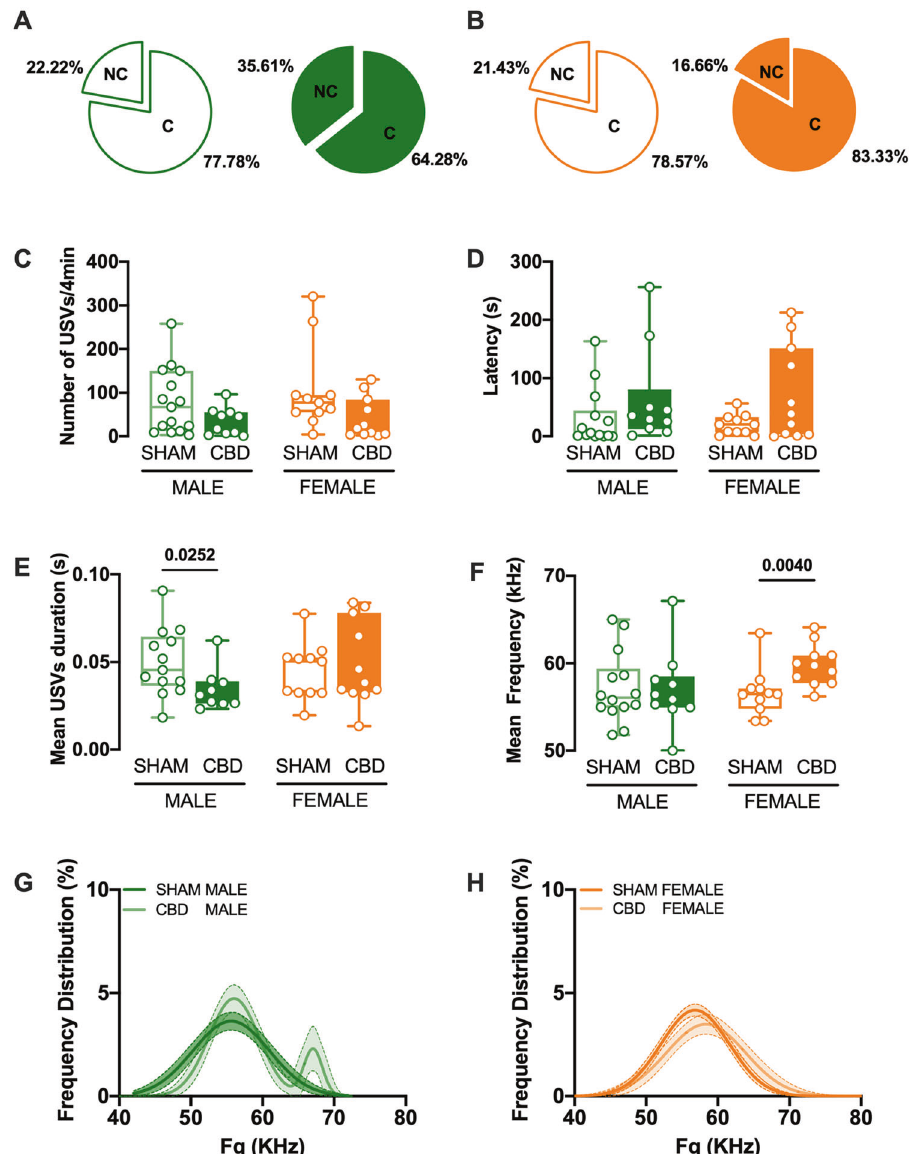
Fig. 2 Fetal CBD modi fi es the frequency and the duration of perinatal USVs. A , B Pie graphs depicting the percentages of vocalizing (C: call) and non-vocalizing (NC: no call) mice, in SHAM and CBD male (left) or female (right) pups. Percentages were calculated as number of animals vocalizing or not / total number of tested animals. Quantitative analysis of USVs shows that following CBD prenatal exposure, the total number of USVs ( C ) and the latency to the fi rst vocalization ( D ) were like those of sham, in both sexes. In contrast, mean duration ( E ) and mean frequency ( F ) of emitted calls were modi fi ed in a sex-speci fi c manner in the CBD progeny. The mean call duration was shorter in CBD male, while the mean frequency was higher in CBD females, compared to their respective SHAM group, (SHAM MALE N = 14 light green, CBD MALE N = 10 dark green, SHAM FEMALE N = 11 light orange, CBD FEMALE N = 11 dark orange). Data are represented as Box and whisker plots ( fi rst quartile, median, third quartile). Individual data points represent a single animal. Multiple Mann – Whitney U test, * p < 0.05. G The average distribution of call frequency was monomodal (i.e., fi tted with a single Gaussian function, dark green) in SHAM male, but bimodal (i.e., fi tted by the sum of two Gaussians for CBD male, light green). H In contrast, the call frequency was monomodal in SHAM (light orange) and CBD exposed female pups (dark orange). Data are represented as curve fi t (±CI) of the principal frequency ’ s average